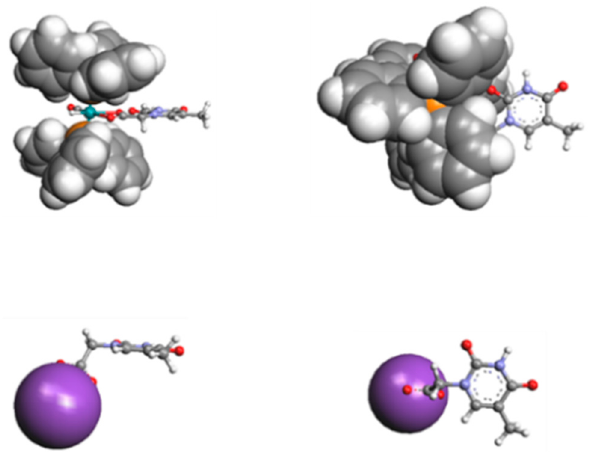
Figure 4. Steric comparison of the hindrance between THAcK and κ 2 -(O,O)[RuH(CO)(THAc) (PPh 3 ) 2